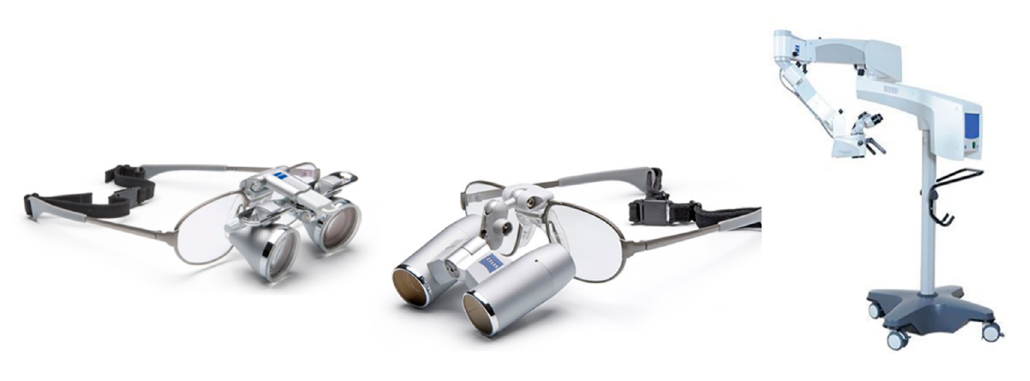
Figure 1. Galilean loupes (the ones used in the trial), Keplerian loupes (another widely adopted surgical magnification tool), and an operating microscope (Movena) Zeiss ® , Jena, Germany.